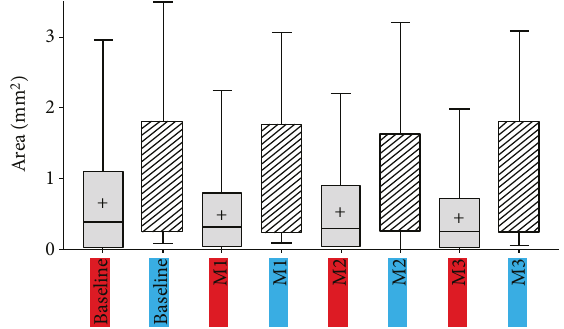
Figure 3: Box-and-whisker plot showing the comparison of CNV size between groups A and B. Group A (grey box on the plot; group A consists of treatment-naïve patients undergoing monthly loading phase) and group B (stripped box; group B consists of treated patients undergoing treatment according to a pro re nata regimen). Note that at baseline the treatment-naïve patients (grey box) had a smaller lesion size than the patients that had already been treated by anti-VEGF (stripped box). During the loading phase, treatment-naïve patients showed a statistically signi fi cant decrease in CNV size ( P = 0 02 ), while the treated patients undergoing PRN regimen demonstrated a slight increase in the lesion size ( P = 0 93 ) at month